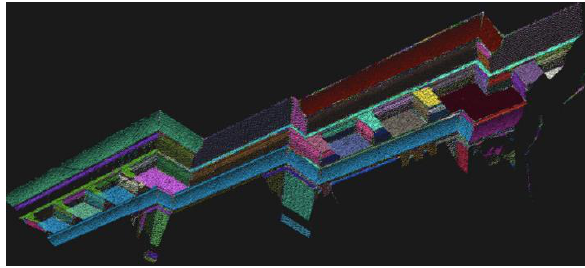
Figure 3: Point cloud segmented with a region growing algorithm available in the Point Cloud Library (PCL).